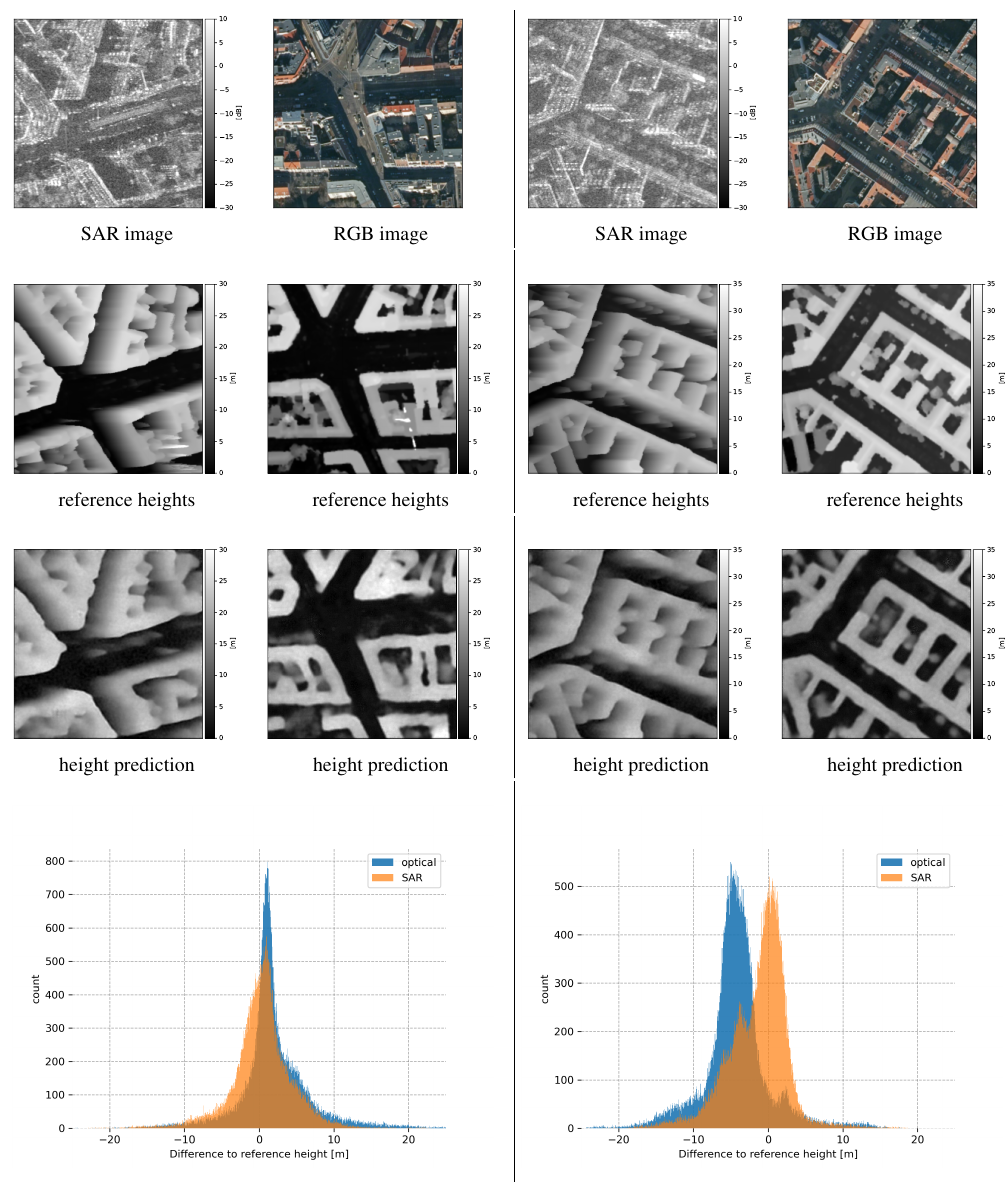
Figure 3. Two randomly selected example images from the test sets, depicted for both the SAR case (columns 1 and 3), and the optical case (columns 2 and 4). The bottom subfigure displays the corresponding error